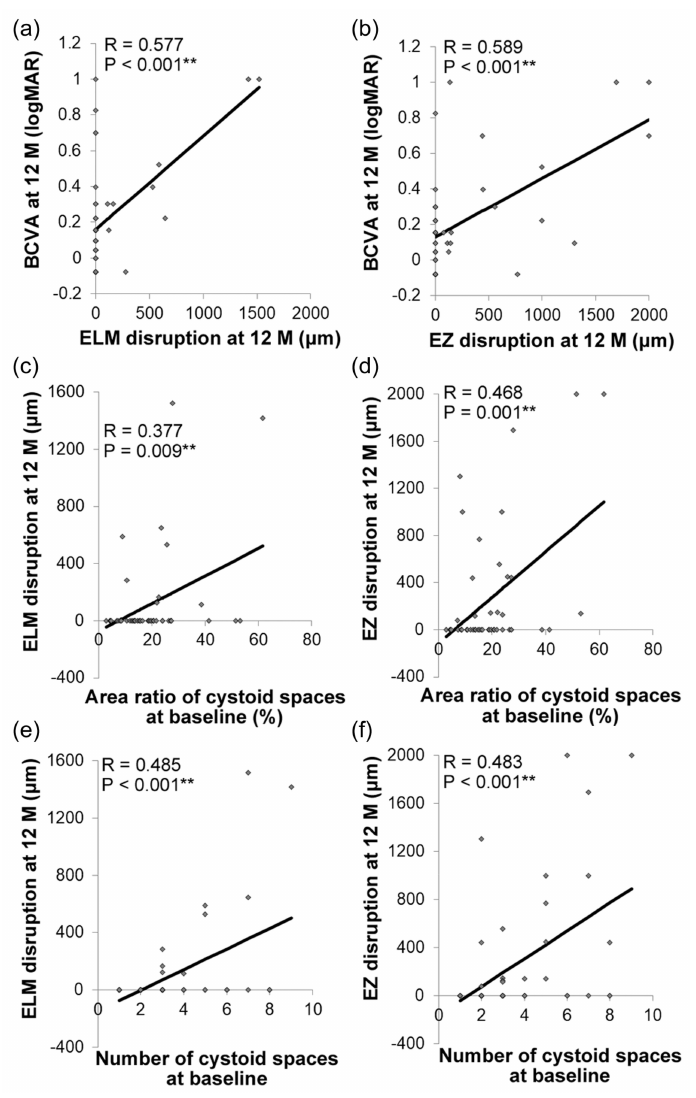
Figure 4. Association of the area ratio and number of intraretinal cystoid spaces at baseline with the outer retinal structures at 12 months. Pearson correlation coe ffi cient. Best-corrected visual acuity (BCVA) at 12 months was correlated with the extents of external limiting membrane (ELM) ( a ) and ellipsoid zone (EZ) ( b ) disruptions at 12 months. The area ratio ( c , d ) and number ( e , f ) of intraretinal cystoid spaces at baseline were positively correlated with the extents of ELM and EZ disruptions at 12 months. ** p < 0.01. Table 3. Association of area ratio and number of intraretinal cystoid spaces at baseline and outer retinal structures at 12